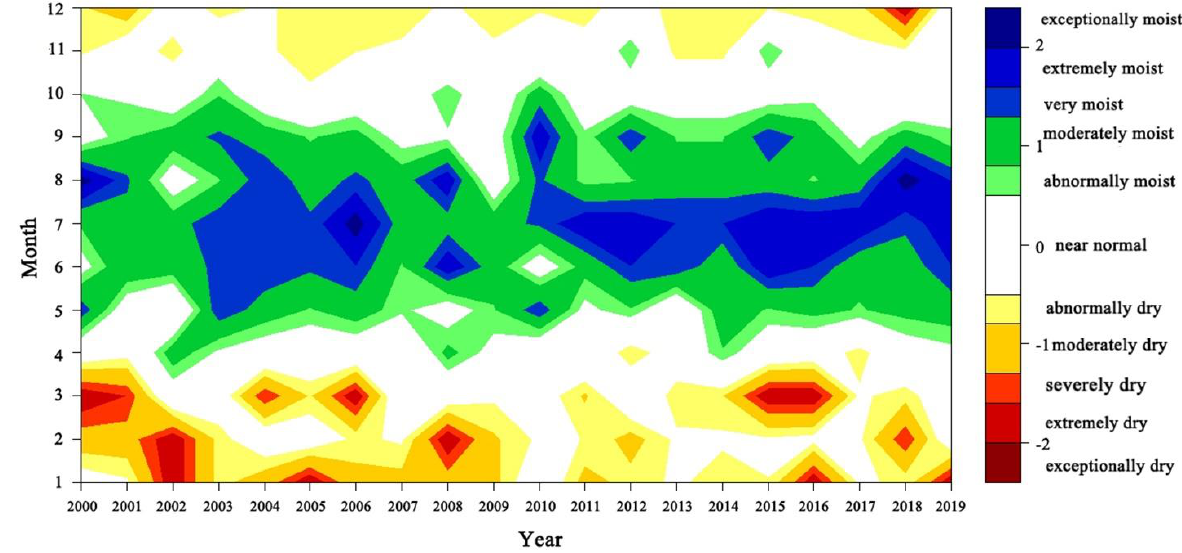
Figure 3. SPI results: The SPI is drought index that is widely used including by the World Meteorological Organization. It reflects the regional drought and flood situation in a given time scale by calculating the cumulative probability of rainfall. The time scale in this study of the SPI was 3 months.